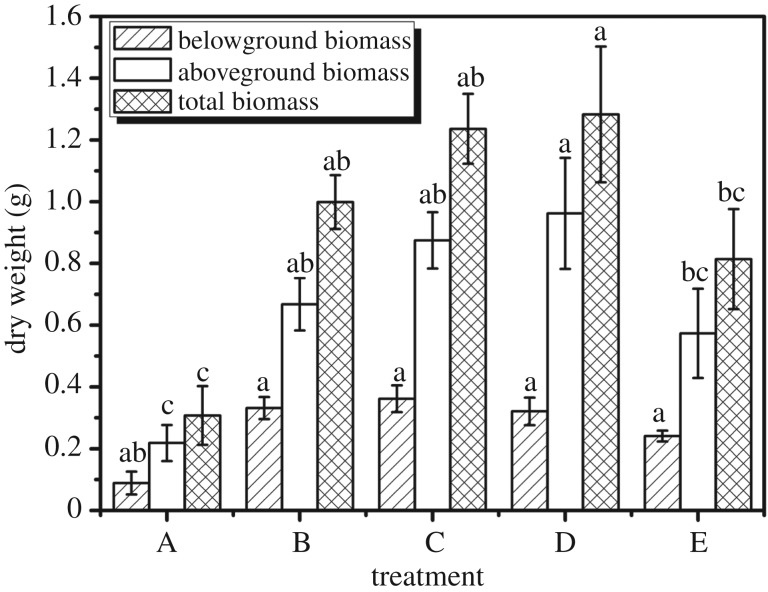
Belowground biomass, aboveground biomass and total biomass under different experimental treatments: (A) water, (B) one-third swollen SAPs, (C) moiety swollen SAPs, (D) one-third no-treatment SAPs, water, and (E) moiety no-treatment SAPs, water. Each value represents the mean ± s.e. (n = 30). The different lowercase letters indicate significant differences (p < 0.05) among treatments as determined by Duncan's test.